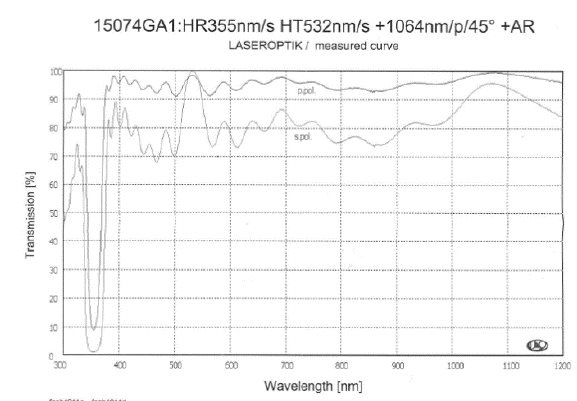
Figure 3:Transmission of the two mirrors in the emitting path